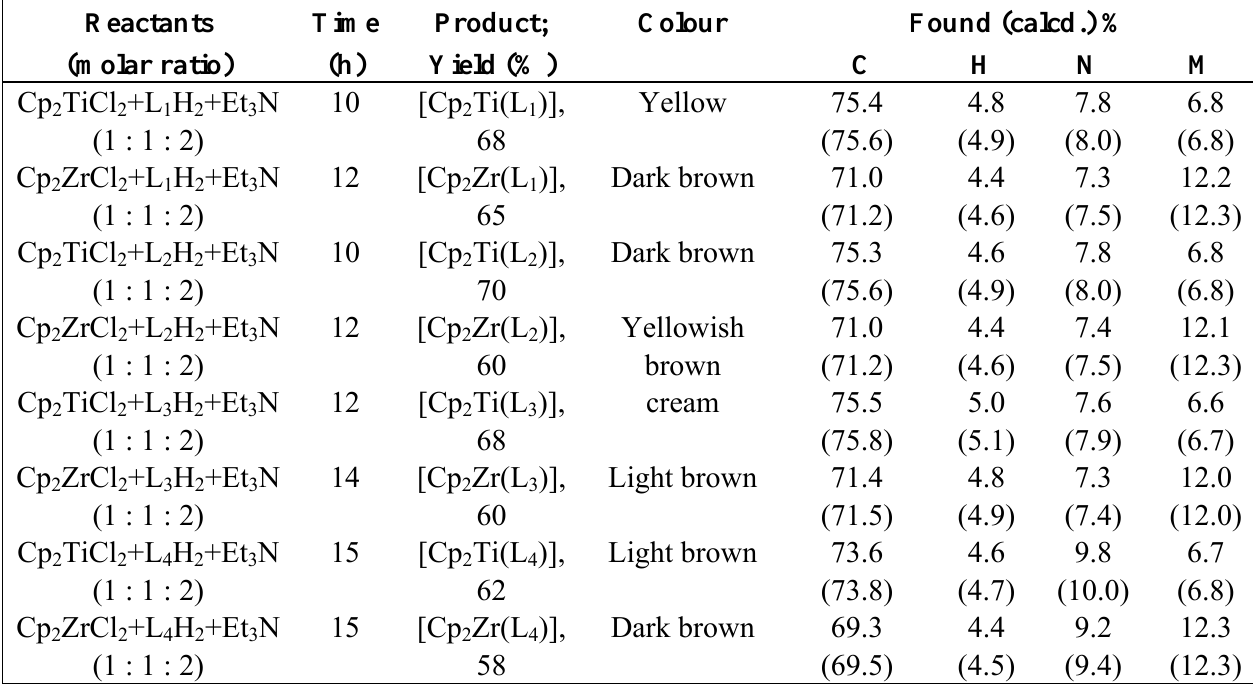
Table 1. Characterization data of titanium(IV) and zirconium(IV) complexes Reactants